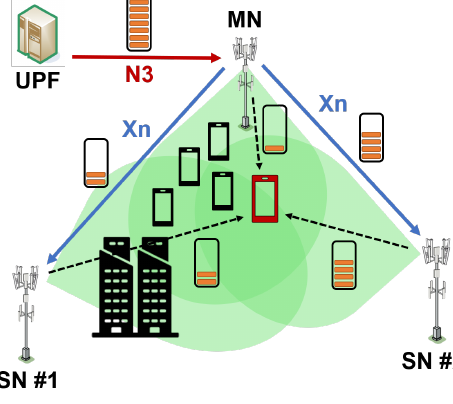
Figure 2. Use case of the traffic steering